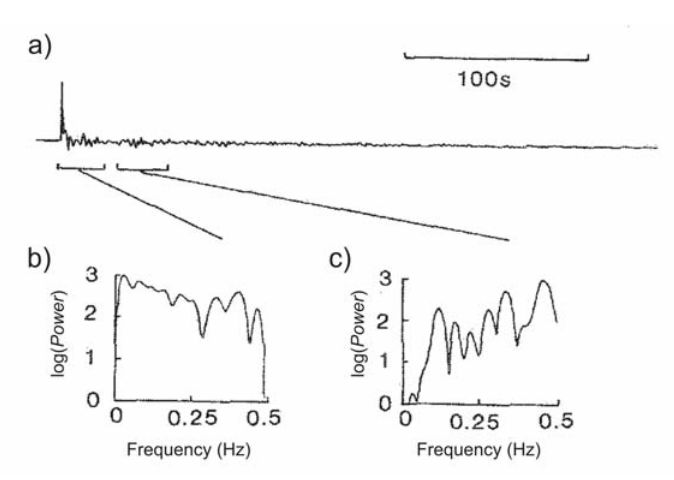
Figure 5. Transmission responses of a simulated 100-boundary sequence [modified from Richards and Menke 1983]. a) Transmitted record that resulted from a single initial pulse. b) Power spectrum of its initial part (main pulse with early forward scattering). c) Spectrum of the later forward-scattered